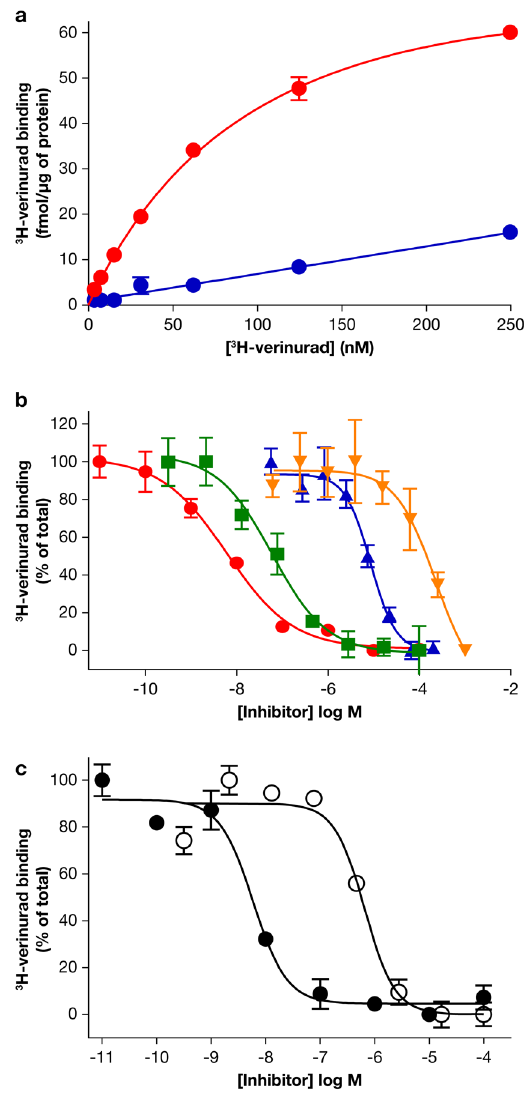
Figure 7. A novel URAT1 binding assay replicates the results of inhibition of URAT1 activity. ( a ) 3 H-verinurad bound specifically to human URAT1. 3 H-verinurad bound to membranes from cells transfected with human URAT1 in a specific and saturable manner (red) but not to membranes from cells transfected with empty vector (blue). ( b ) 3 H-verinurad binding to human URAT1 was blocked by URAT1 inhibitors in a dose-dependent manner. 10 nM of 3 H-verinurad was incubated with human URAT1 membranes and different concentrations of unlabeled verinurad (red), benzbromarone (green), sulfinpyrazone (blue) and probenecid (orange). ( c ) 3 H-verinurad bound to membranes from cells transfected with human URAT1-F449Y, which was blocked in a dose-dependent manner by unlabeled verinurad (filled circles) and by benzbromarone (open circles). Compared to human URAT1, h-F449Y has the same affinity for verinurad but an 11-fold lower affinity for benzbromarone, mimicking the results for the activity assay (Fig.